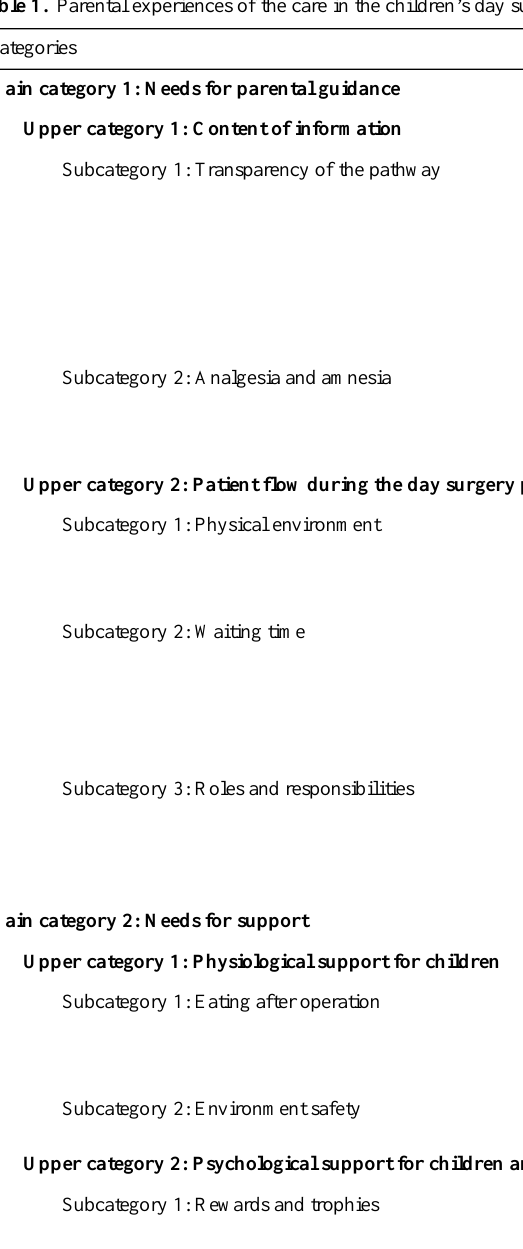
Table 1. Parental experiences of the care in the children’s day surgery